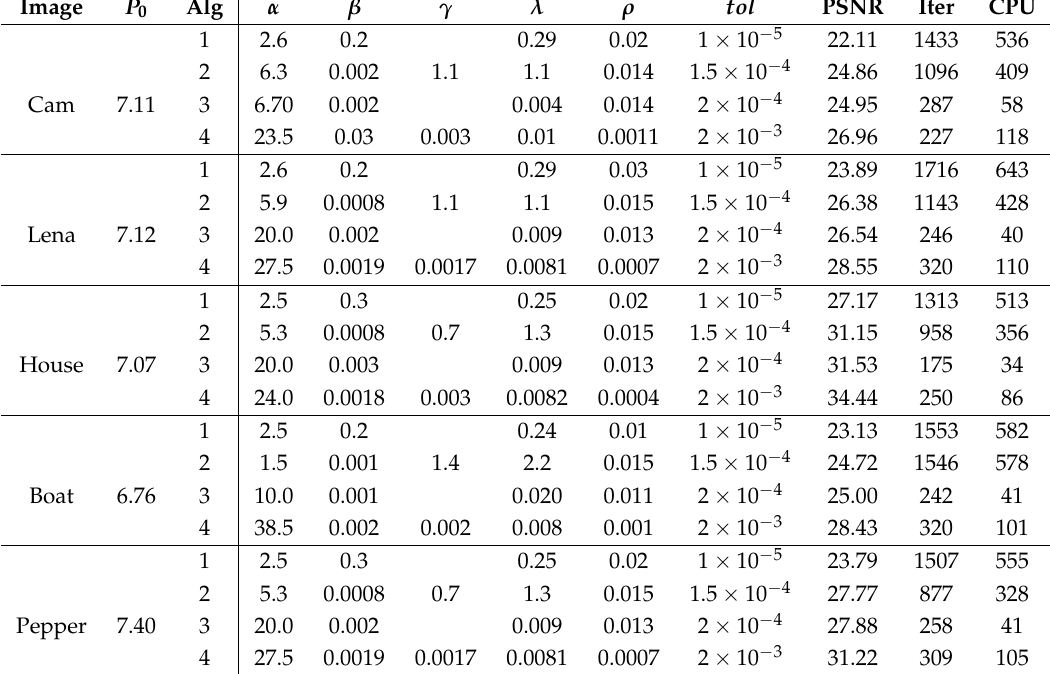
Table 3. Numerical results for TVL1 problems with 60% salt-and-pepper impulse noise. Image